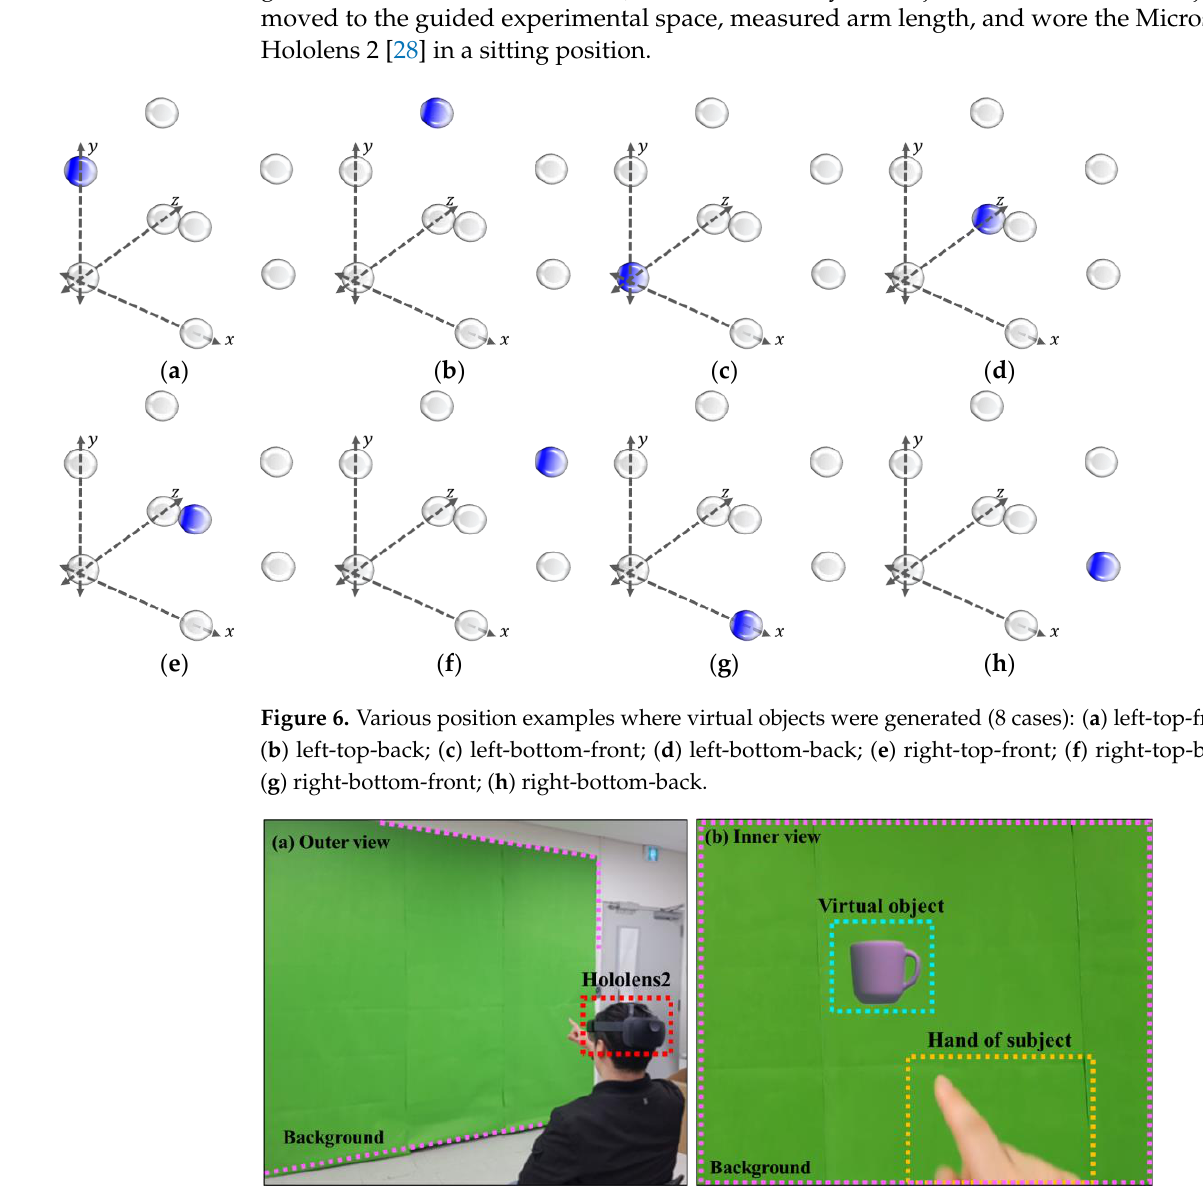
Figure 7. Subject’s two views of subject in MR experiment: outer view and inner view through Figure 7. Subject ’ s two views of subject in MR experiment: outer view and inner view through Ho- lolens2: ( a ) outer view, ( b ) inner view. Hololens2: ( a ) outer view, ( b ) inner